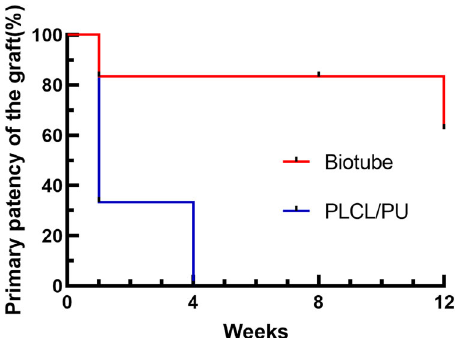
Fig. 6 Kaplan – Meier curves showing primary patency of the grafts in the biotube group(Red line) and PLCL/PU group (Blue